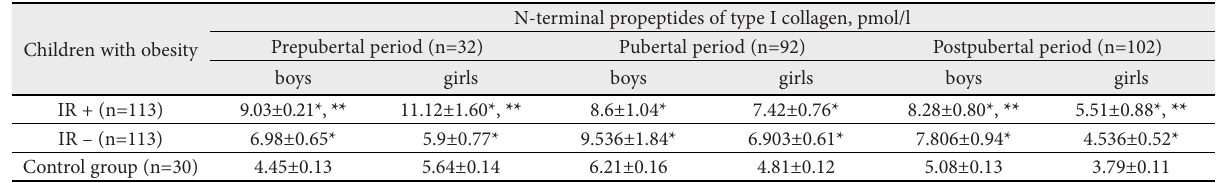
The levels of N-terminal propeptides of type I collagen in children with obesity (M±σ) Children with obesity